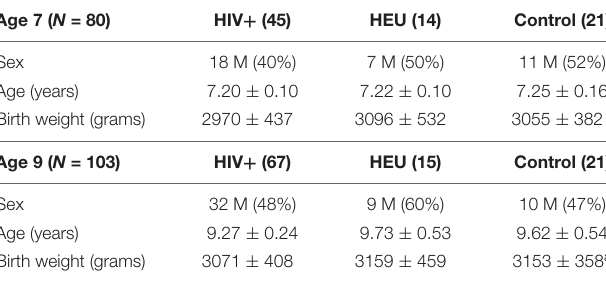
TABLE 1 | Biographical data for HIV + , HIV-exposed uninfected (HEU), and HIV-unexposed uninfected controls scanned at 7 and 9 years.